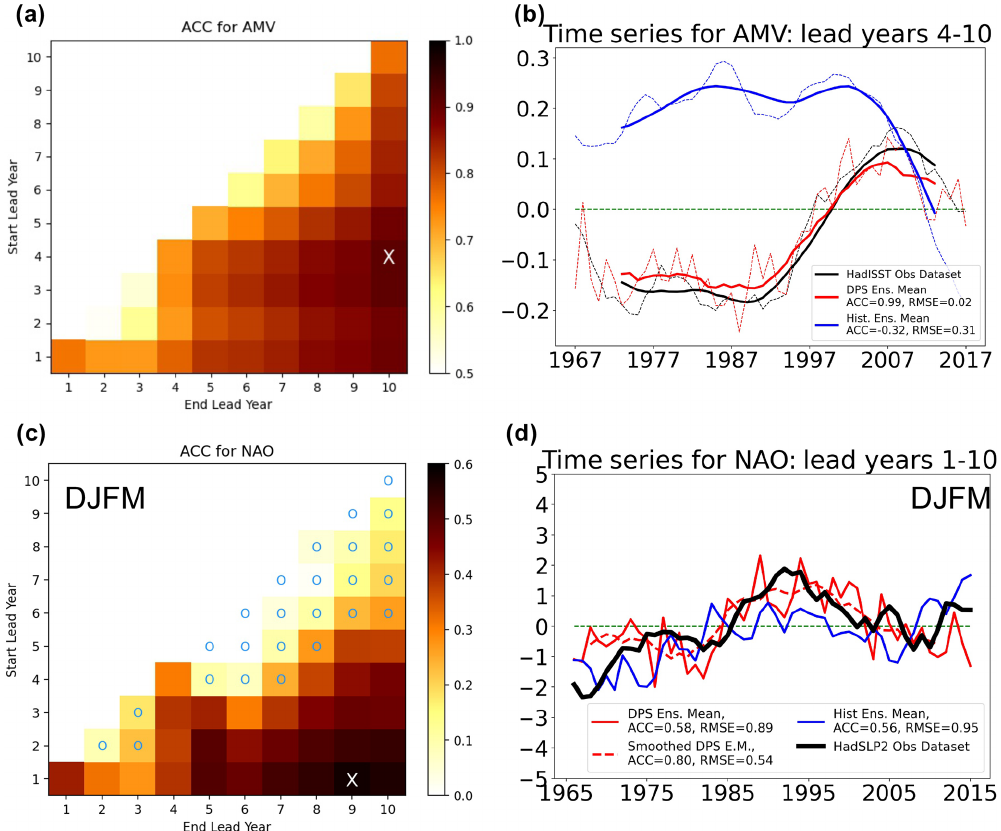
Figure 9. (a) ACC for AMV index. The color bar ranges from 0.5 to 1. The cyan markers indicate statistically insignificant correlations. The white cross denotes the maximum value (ACC = 0.91). (b) Observed and predicted AMV index for lead years 4–10 (in which ACC is maximum). Panel (c) is the same as panel (a) but for the December–March (DJFM) NAO index. The color bar ranges from 0 to 0.6 (maximum ACC = 0.58). (d) Observed and predicted NAO index for lead years 1–9 (in which ACC is